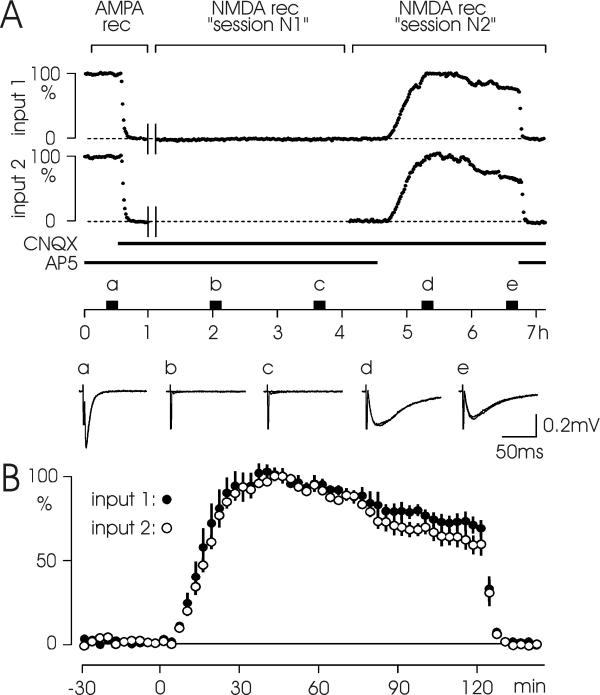
Activation of NMDA receptors is necessary for inducing persistent depression. (A) Experimental design: Measurements of field EPSPs are plotted for a representative experiment as in Fig. 1A. The experiment conformed with the previous one except that AP5 was present in the solution during session N1. Accordingly, synaptic transmission was blocked for the entire period when input 2 was stopped. In session N2, AP5 was eventually washed out and both inputs displayed decaying NMDA EPSPs. Samples of recorded potentials of both inputs are given for the indicated time points a-e. (B) Superimposed averaged time courses of NMDA EPSPs from both inputs during session N2. Each point represents the average of measurements within 3 min intervals. The peak of input 2 was chosen as 100 %. The equal appearance of the curves shows that no pathway specific depression remained during N2 due to the differential treatment during N1 (compare such a depression in the reference case in Fig. 1C). Values are expressed as mean ± S.E.M (n = 5 experiments).